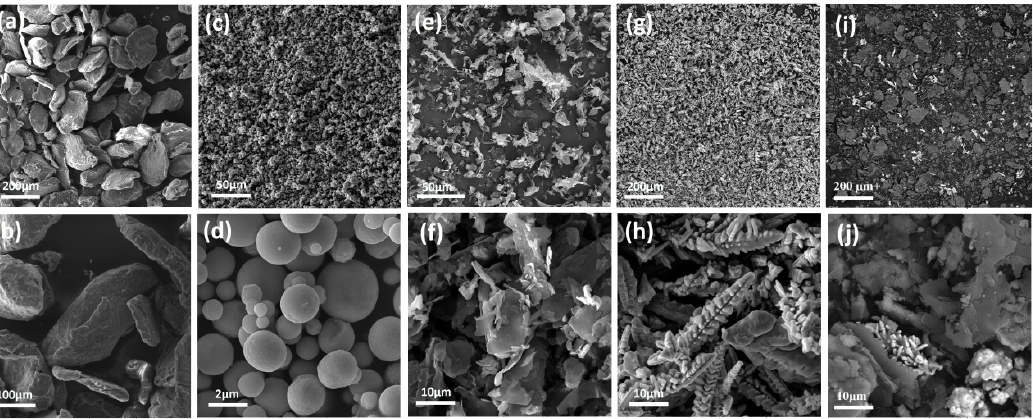
Figure 2. SEM micrographs of ( a , b ) Mg, ( c , d ) Zn, ( e , f ) GO, ( g , h ) Cu and ( i , j ) MZ/Cu-GO powders.